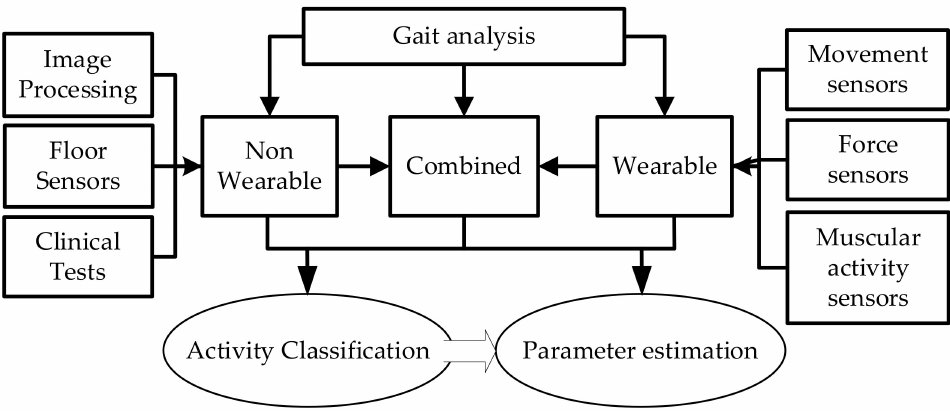
Figure 1. Classification of gait analysis systems. Gait analysis can be achieved using non-wearable and/or wearable systems. Both systems can achieve similar types of results but with significant differences in price, usability, resolution and accuracy.